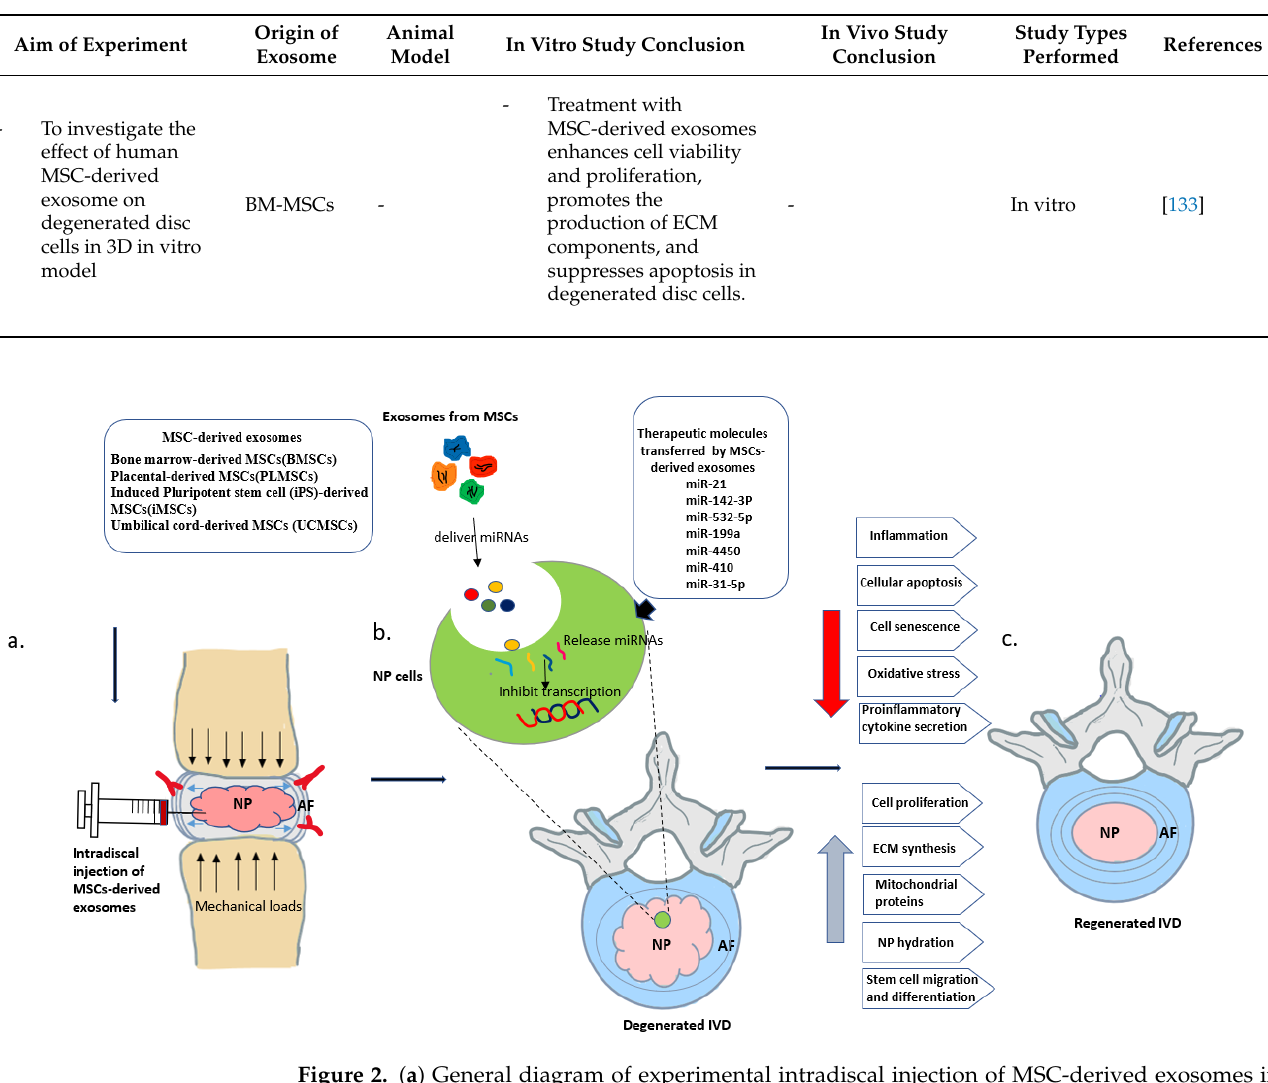
Figure 2. ( a ) General diagram of experimental intradiscal injection of MSC-derived exosomes in a degenerated IVD. ( b ) In NP cells of the degenerated IVD, therapeutic molecules (miRNAs) are transferred by MSC-derived exosomes that inhibit the translation process, thereby regulating multiple intracellular processes, including cell proliferation, apoptosis, and cytokine release. ( c ) Regeneration of IVD after MSC-derived exosomes treatment with an increase in cell proliferation, ECM synthesis, and NP hydration, and upregulation of mitochondrial proteins.